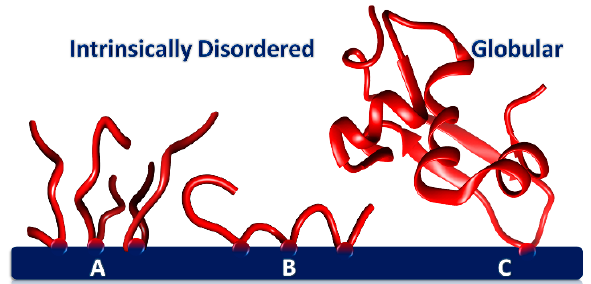
Figure 2. Phosphoproteins adsorbed onto a CaP surface through one or more CaP-SLiMs. ( A ) Tightly packed layer of flexible, short acidic peptides with a single CaP-SLiM ( B ) IDP with three CaP-SLiMs (e.g., OPN 1–149) forming two loops and two trains. A protein such as phosphophoryn has many CaP-SLiMs and as a result adopts a more sessile conformation on the surface. ( C ) Globular protein adsorbed through a single CaP-SLiM but with a large footprint.